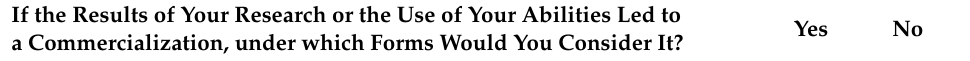
Table 3. Question used to construct the dependent